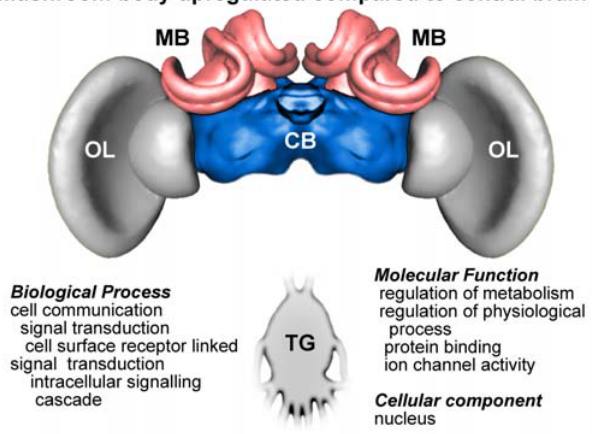
Figure 2. Results of GO enrichment analysis of genes that showed consistent differences in gene expression across the three honey bee species in the mushroom bodies compared to central brain.